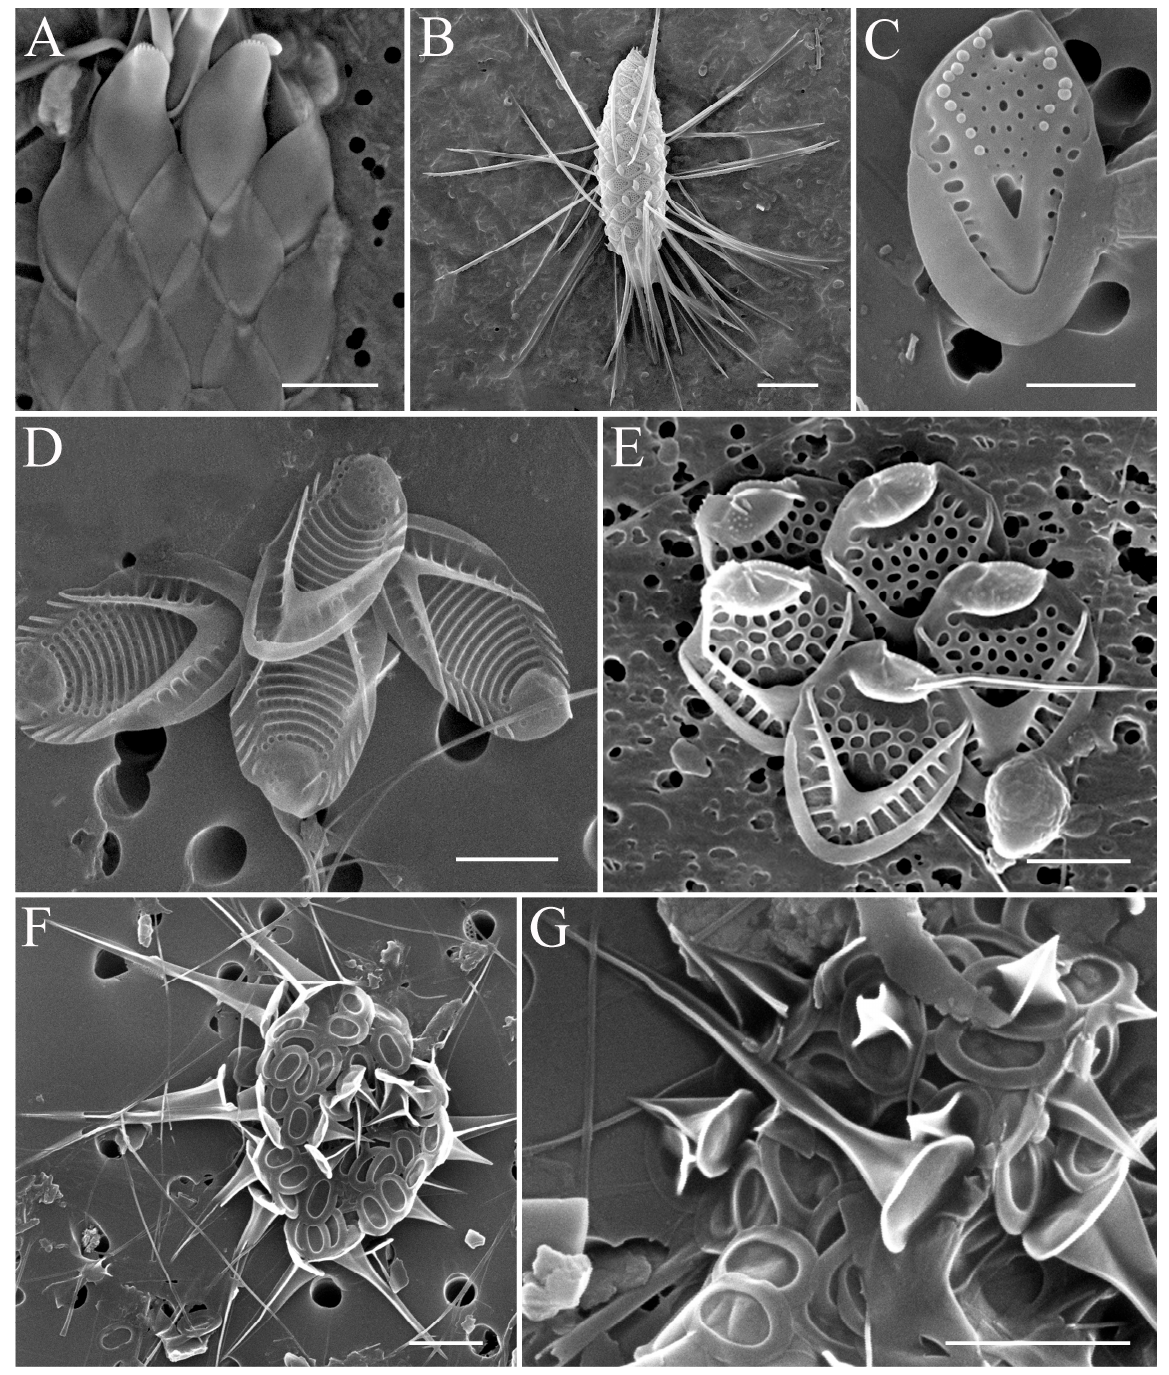
Figure 4. Silica-scaled chrysophytes from lakes Labynkyr and Vorota SEM: ( A ) M. akrokomos ; ( B , C ) M. crassisquama var. papillosa ; ( D ) Mallomonas sp. 2; ( E ) M. crassisquama var. crassisquama ; ( F , G ) Spiniferomonas heterospina sp. nov. Scale bars: ( A , C–G ) 2 μ m; ( B ): 10 μ m.